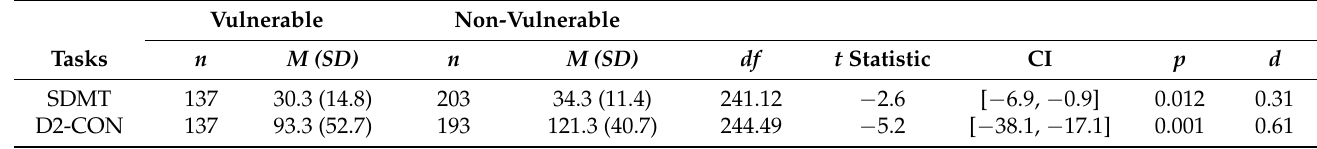
Table 2. Attention tests raw scores and independent samples t -test